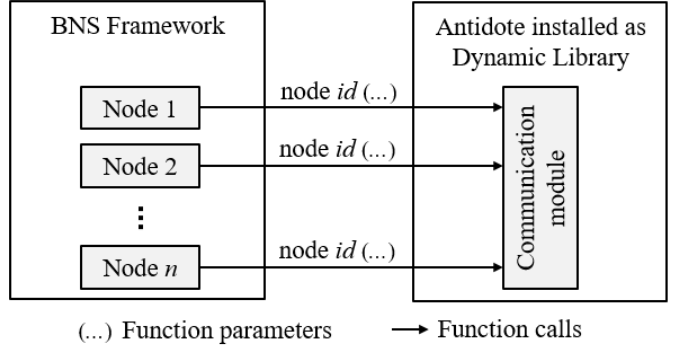
Figure 7. Communication module handling several